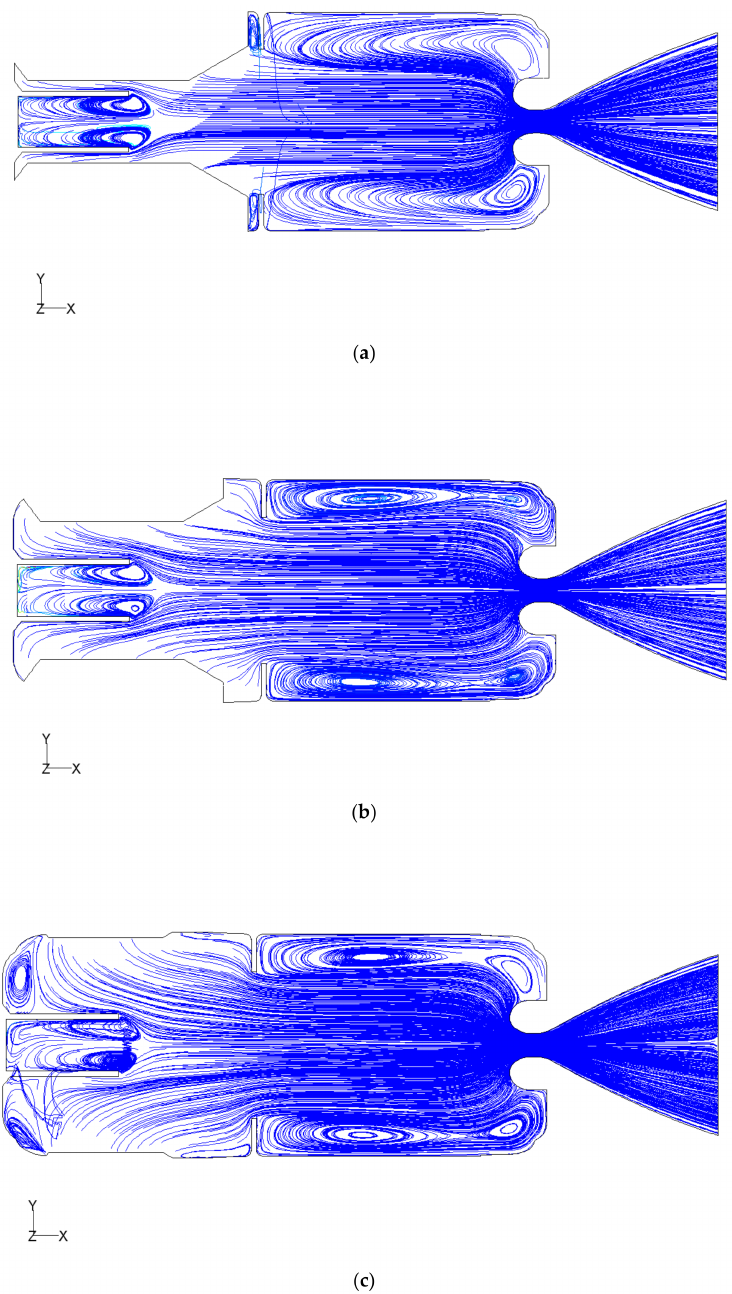
Figure 5. The contour of the gas tracks at different times: ( a ) t = 2 s; ( b ) t = 7 s; ( c ) t = 14